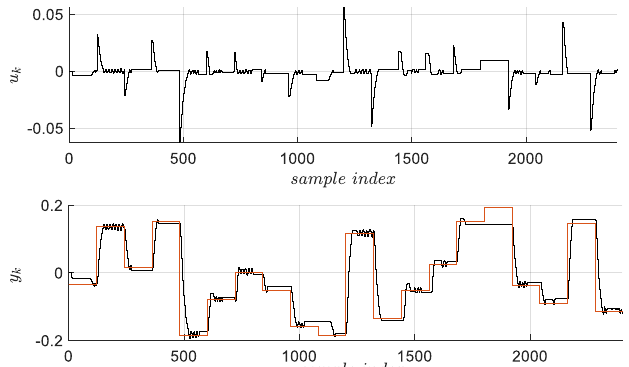
Figure 2. I/O data collected from the closed-loop visual servo system.